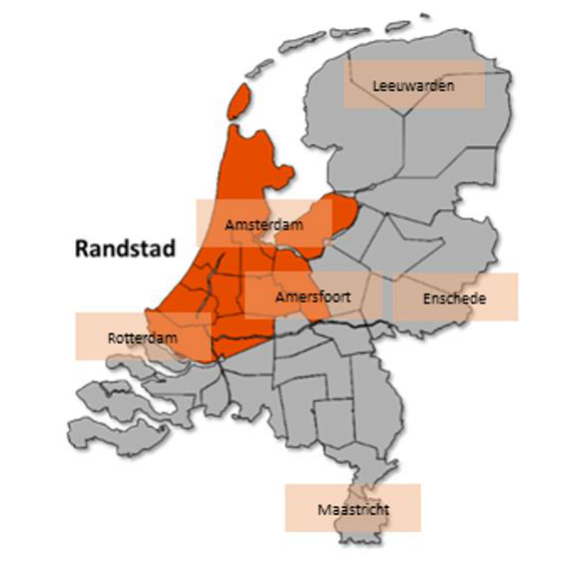
Figure 2 Randstad (contract) areas in